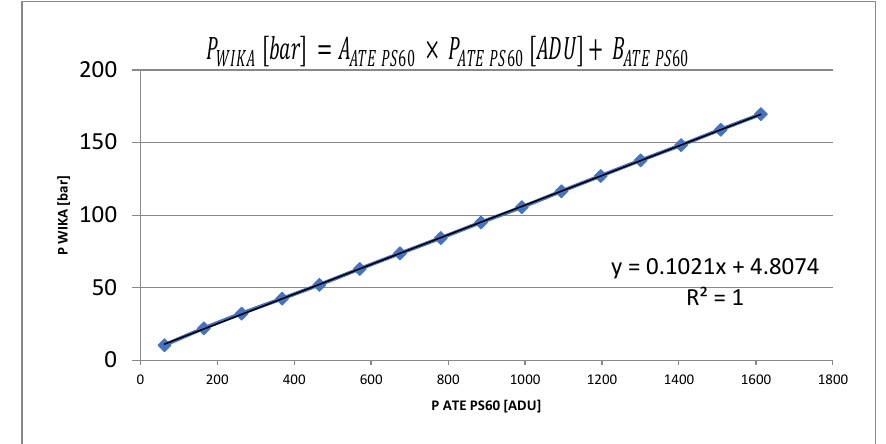
Figure 5. Measured pressure system transfer curve for pressure sensor ATE PS60, dependence between pressure sensor ATE PS60 output voltage in ADU (Analog Digital Unit) units and pressure in bar from portable measurement device WIKA CPH 6200 (see Equation (1)).